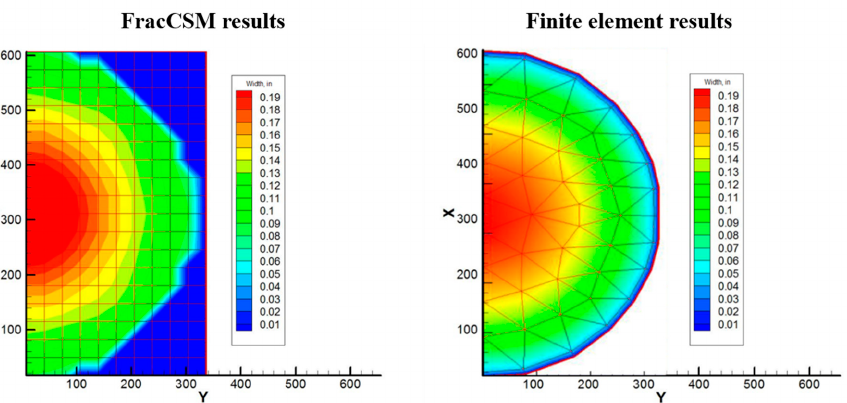
Figure 7. Simulated fracture width after 30 min injection. The right sub-figure is modified from [50].